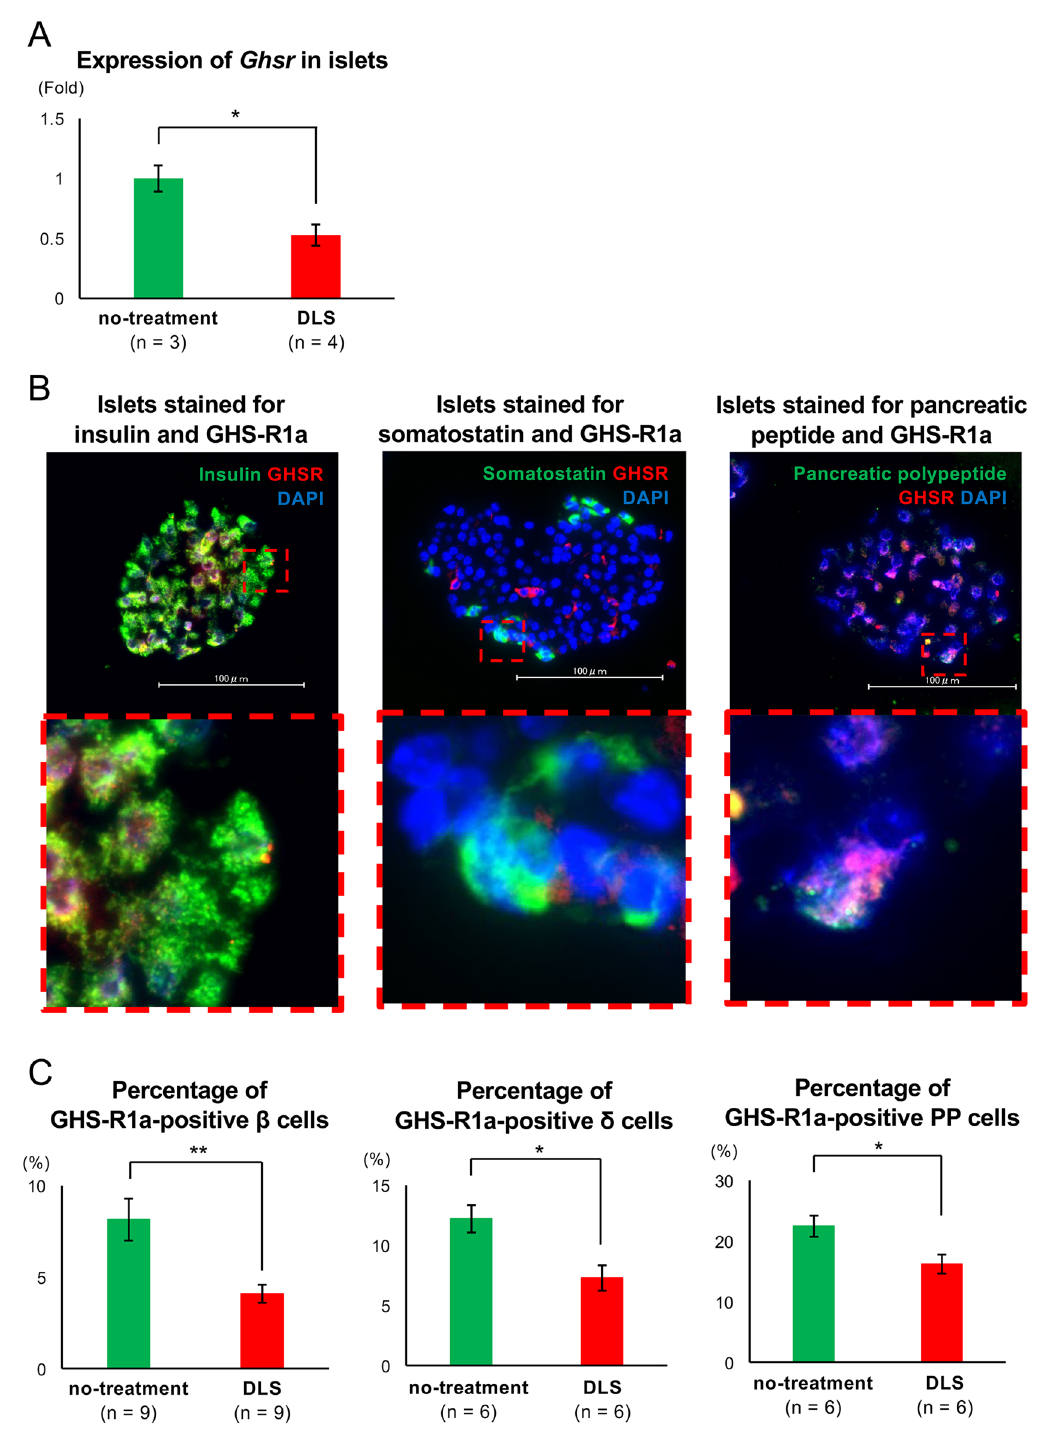
Figure 1. Expression of GHS-R1a on islets. ( A ) Expression of Ghsr in islets with and without DLS treatment. Gene expression was quantified using real-time RT-PCR with Actb as the internal control. ( B ) Histological findings of DLS-treated islets stained for insulin ( green: left ), somatostatin ( green: center ), pancreatic polypeptide ( green: right ), and GHS-R1a ( red ). Nuclei were stained using DAPI ( blue ). The size of the scale bar is 100 µm. ( C ) Percentage of GHS-R1a-positive β ( left ), δ ( center ), and PP ( right ) cells per each endocrine cells in both no-treatment and DLS groups. Data are presented as means ± SEMs. P value of < 0.05 was considered statistically significant; * p <